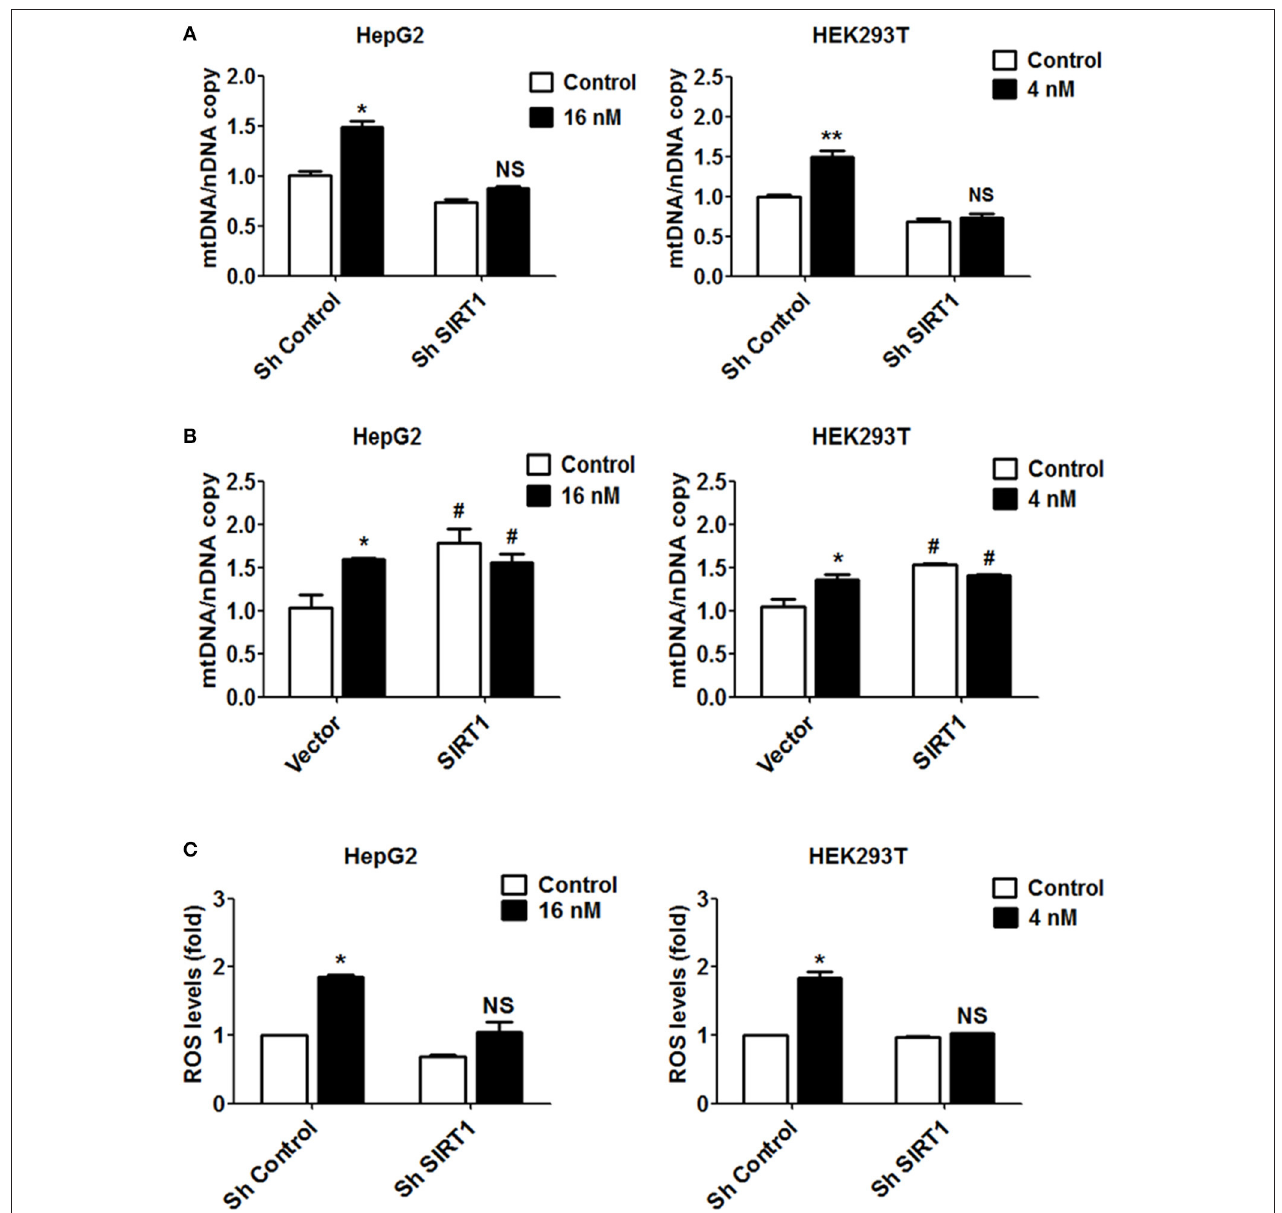
FIGURE 5 | Increased mitochondrial biogenesis and ROS production in response to T-2 toxin treatment require SIRT1. (A) Mitochondrial DNA content analyzed in HepG2 and HEK293T cells with/without knockdown of SIRT1 exposed to T-2 toxin. Left, copies of mitochondrial DNA in HepG2 cells; Right, copies of mitochondrial DNA in HEK293T cells. (B) HepG2 and HEK293T cells overexpressing SIRT1 were treated with T-2 toxin, and the mitochondrial DNA content was determined using RT-qPCR. Left, copies of mitochondrial DNA in HepG2 cells; Right, copies of mitochondrial DNA in HEK293T cells. (C) ROS production in HepG2 and HEK293T cells infected with SIRT1 or nontargeting shRNA after T-2 toxin exposure was tested by a flow cytometry assay after staining with carboxy-H2DCFDA. Left, ROS levels measured in HepG2 cells; Right, ROS levels measured in HEK293T cells. * P < 0.05 and ** P < 0.01 for comparison between the control and T-2 toxin-treated